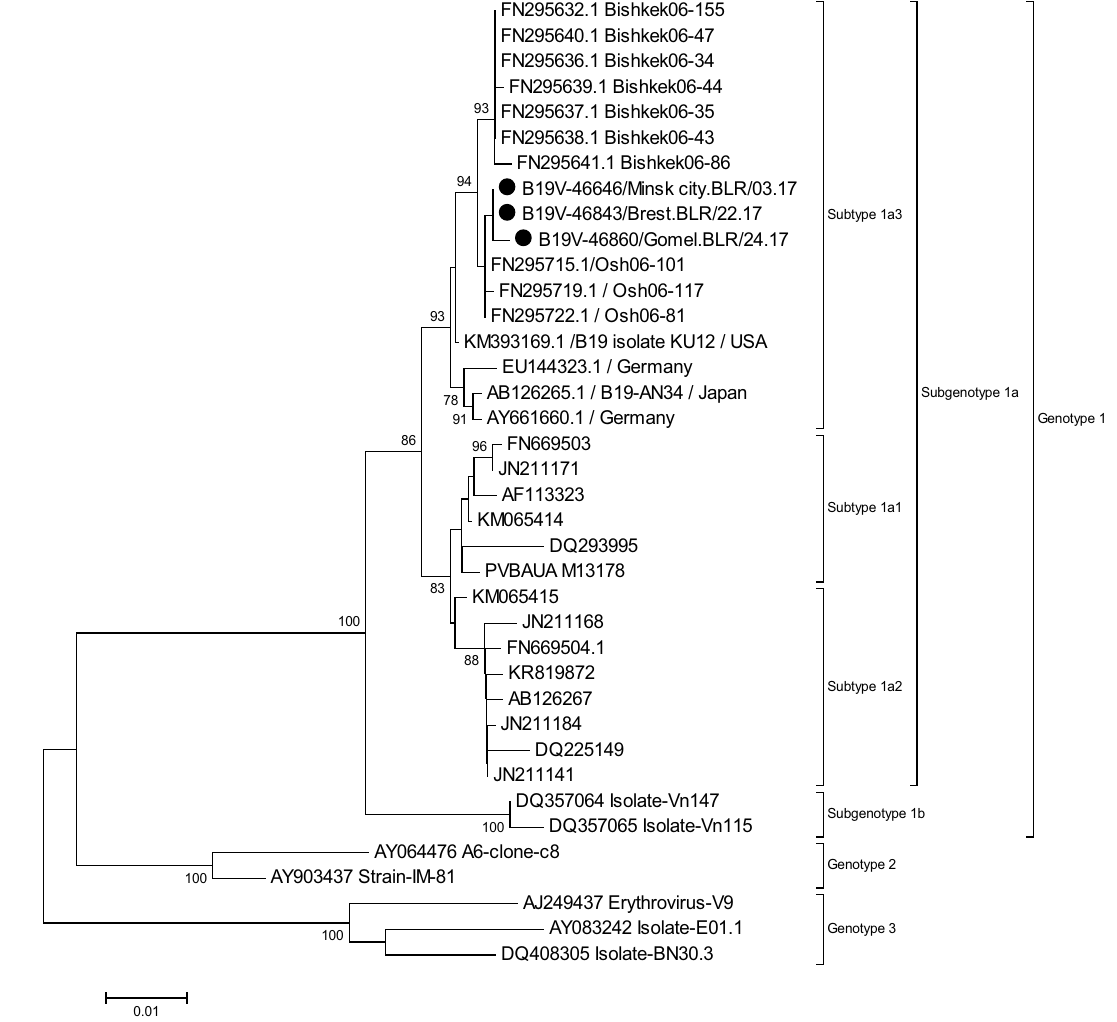
Figure 7. Phylogenetic tree based on 994 nt of the NS1/VP1-unique region junction. All sequences closely related to the 1a3 strains from Belarus available on Genbank were included. The sequences from Belarus are marked with a black dot. Only bootstrap values ≥ 70% (1000 replicates) are